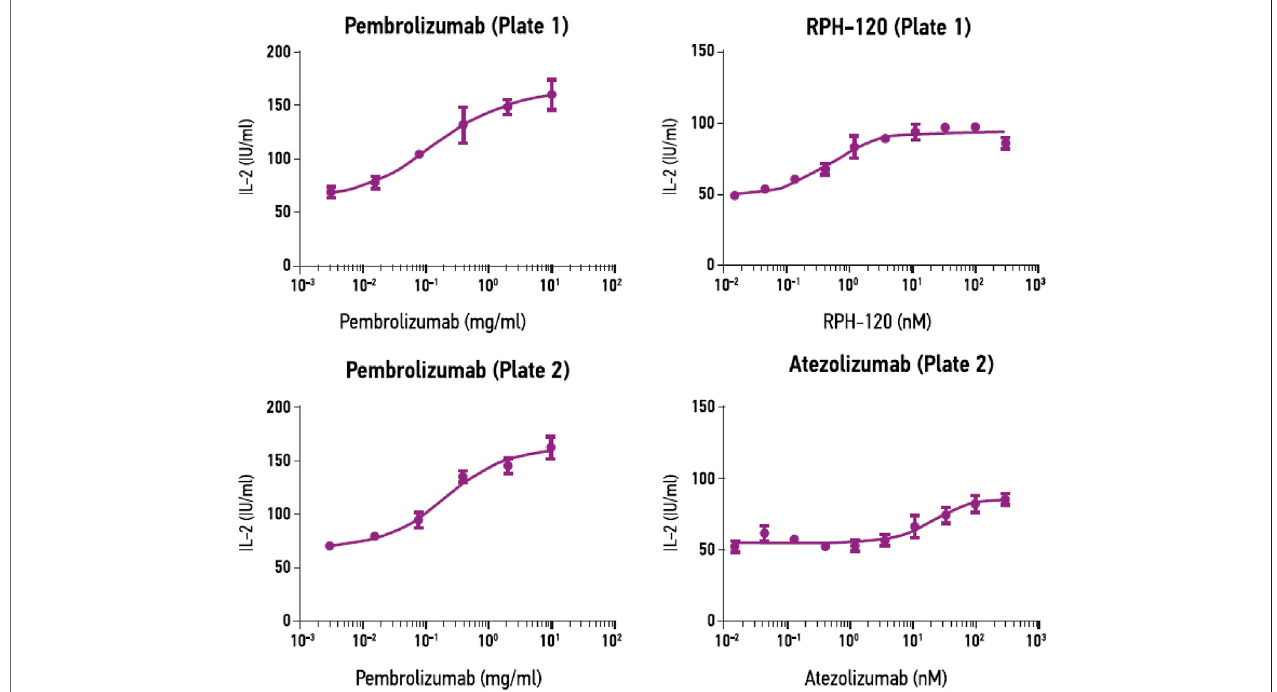
FIGURE 4 | RPH-120 enhances CD4 + T cell activation in MLR. RPH-120 and atezolizumab dose-response curve of IL-2 secretion were monotonous and the experimental points were fi t into a curve using non-linear four-parameter regression algorithm to determine EC50